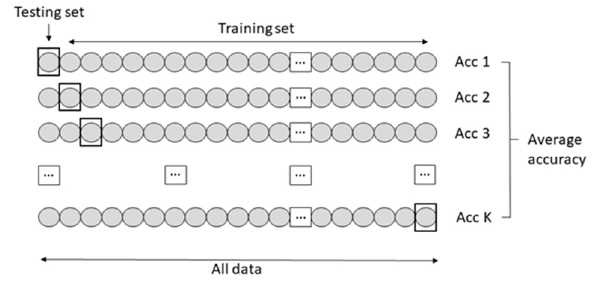
Figure 5. Cross validation workflow.